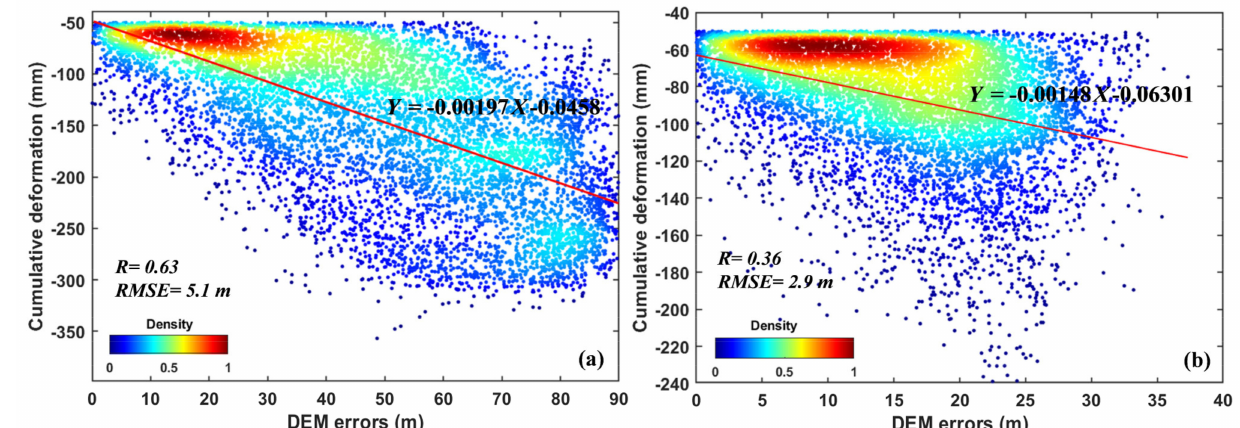
Figure 20. Correlation analyses between surface displacements and thickness of the filling loess in Regions E ( a ) and A ( b ). The red lines indicate the linear fitting between cumulative displacement and DEM errors (i.e., filling thickness), R is the correlation coefficient, and RMSE stands for root mean square